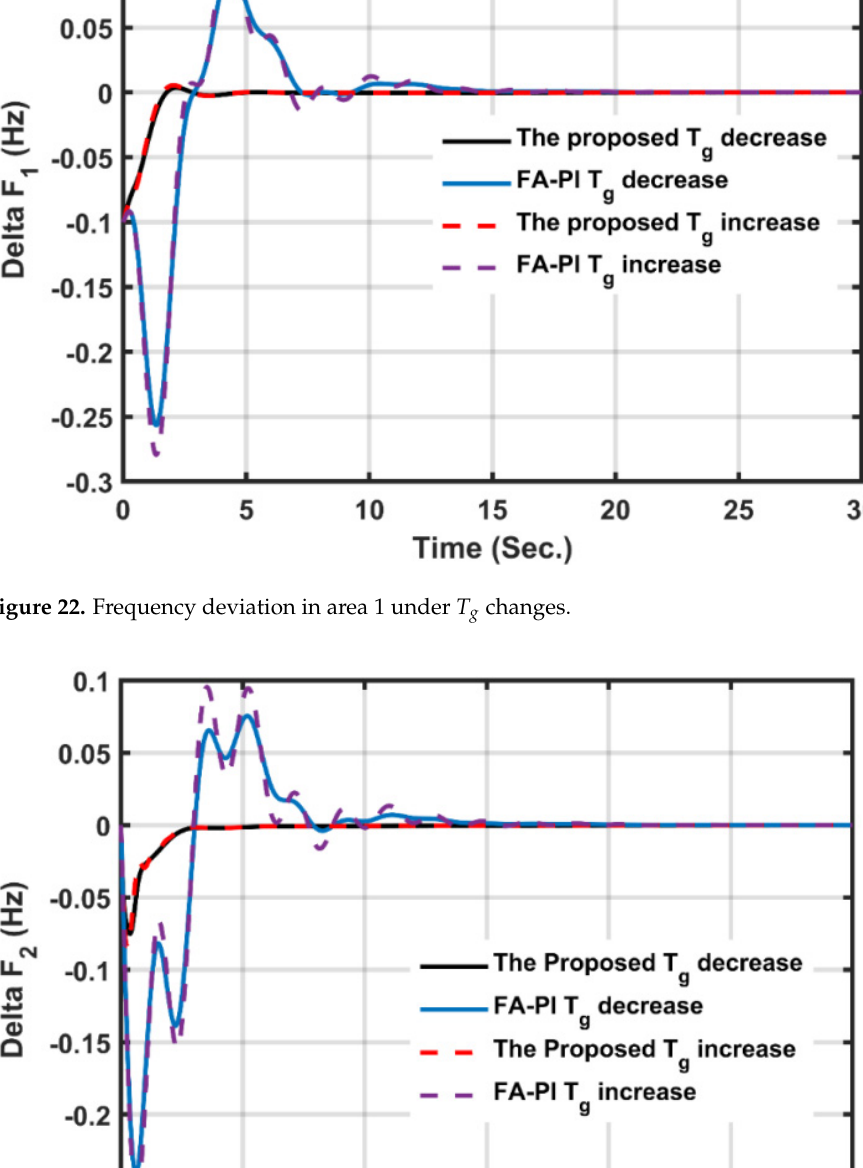
Figure 24. Tie line power deviation under T g changes. Secondly, Figures 25–27 illustrate the frequency deviations in the two areas and the power deviation in the tie line, respectively, when T t is changed by ±40%. The results